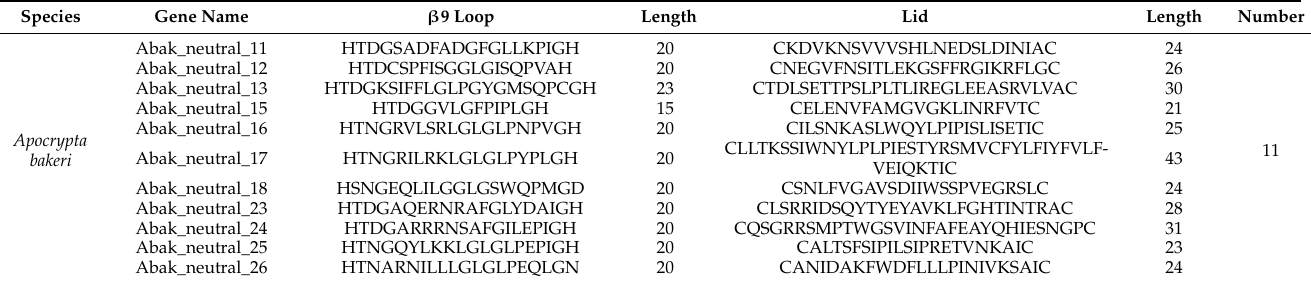
Table 3. Predicted loop and lid domains of neutral lipases in 12 fig wasps. Only insect lipases